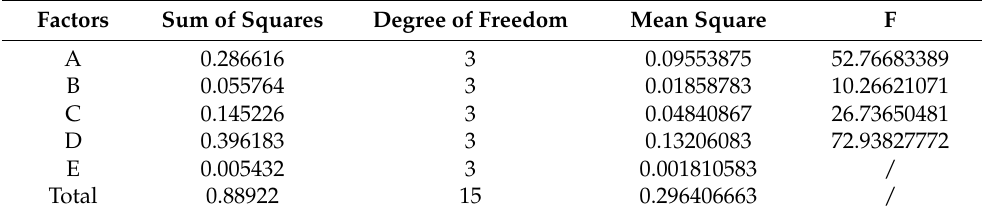
Table 5. Table of ANOVA.